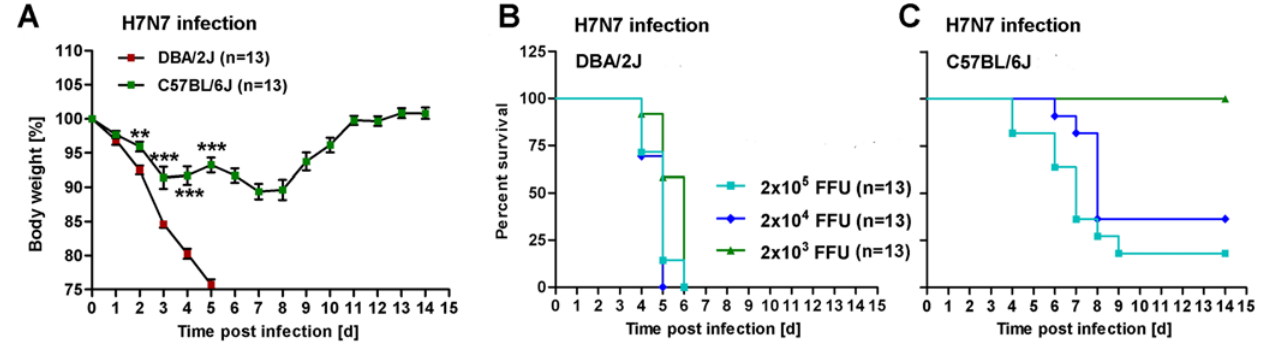
Figure 5. DBA/2J mice are highly susceptible to H7N7 (SC35M) virus infection compared to C57BL/6J mice. (A): DBA/2J and C57BL/6J mice were infected intra-nasally with 2 6 10 3 FFU SC35M virus. DBA/2J (B) and C57BL/6J (C) mice were infected with increasing doses of SC35M (H7N7) virus via the intra-nasal route. Weight loss and survival of infected mice was followed over a period of 14 days. Mortality includes also mice that were sacrificed because they had lost more than 25% of body weight. Data are from two independent experiments. Mean percent of body weight change ( 6 SEM) is shown. DBA/2J and C57BL/6J groups were compared for statistically significant differences using non-parametric Mann-Whitney-U-test. *: p value , 0.05; **: p , 0.01; ***: p value , 0.001.